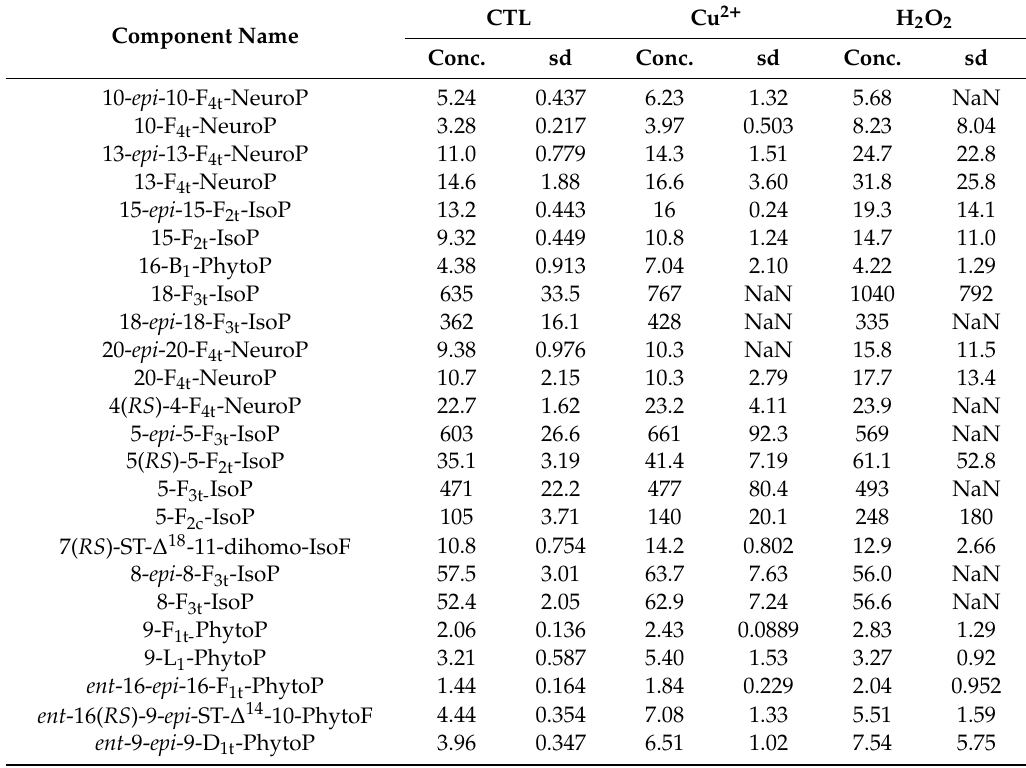
Table 4. Quantification of NEO-PUFAs in C. gracilis incubated under control, copper or H 2 O 2 stress. Data are mean ± sd (n = 3) expressed as ng / g dry weight. NaN stands for Not a Number, because it is an impossible